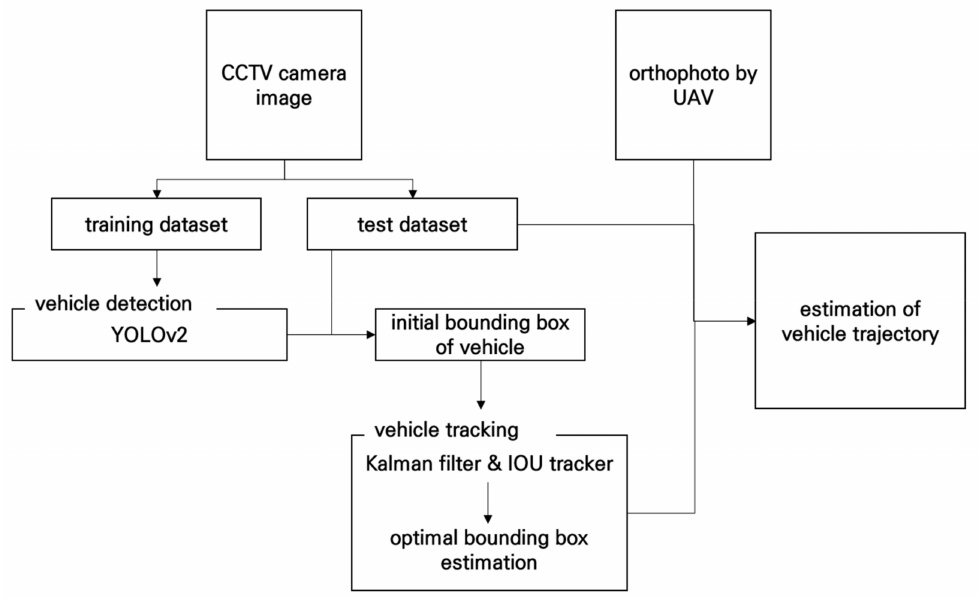
Figure 4. The framework of the proposed methodology.